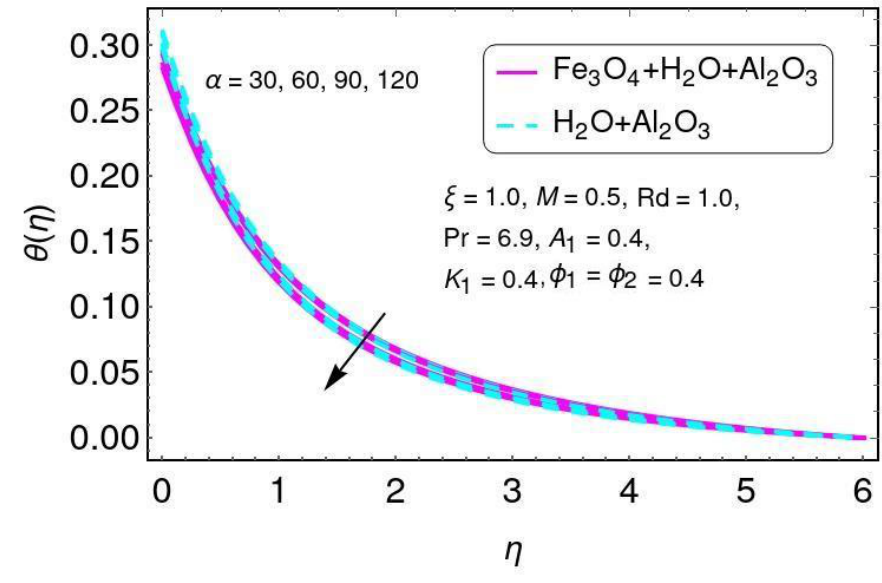
Figure 12. The characteristics of α on the temperature field.